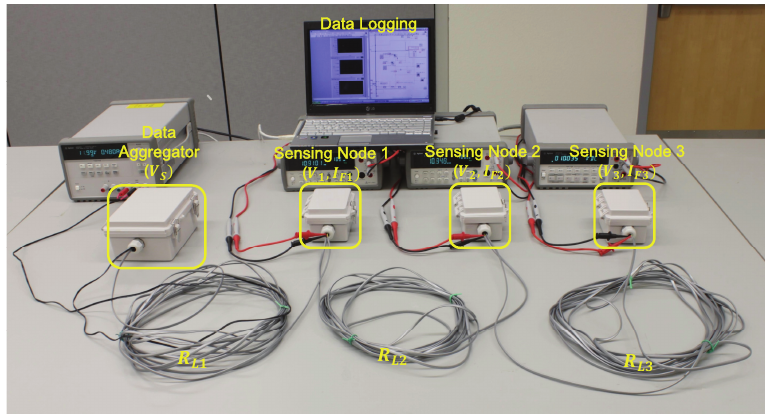
Figure 7. Validation setup using the daisy-chained DuraMote system.